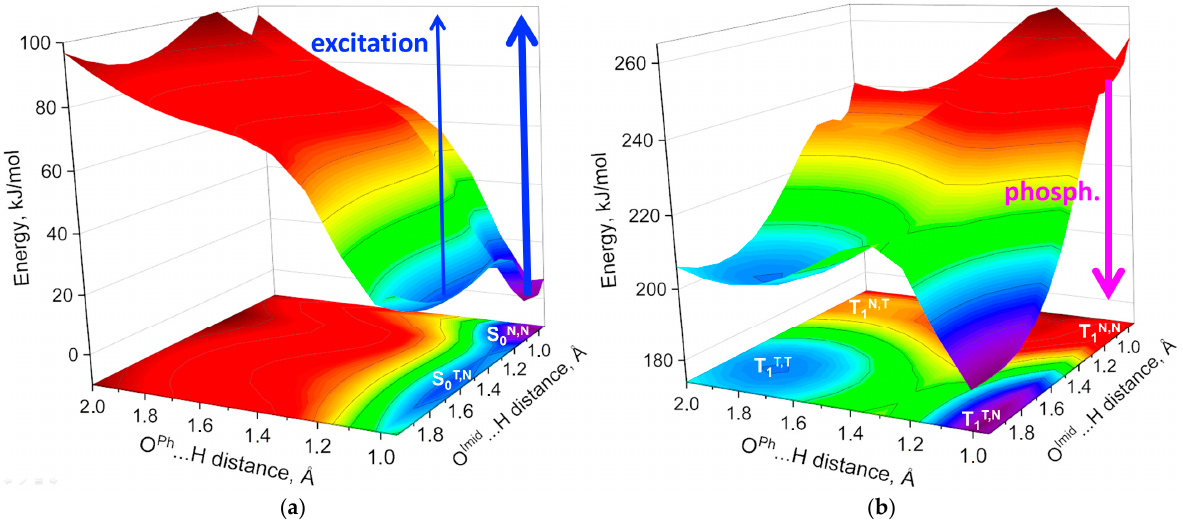
absorption spectrum. In the case of L H,OH , there is only one minimum on the PEC of the ground state, S 0N (Figure 5).